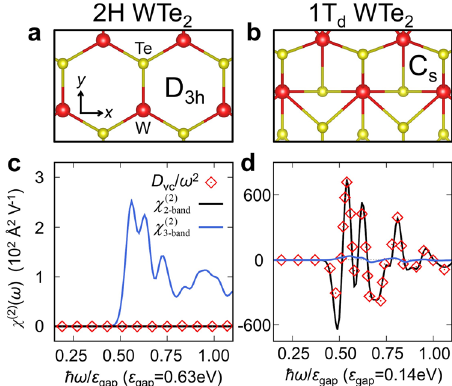
Fig. 4 The second harmonic Hall response of two polymorphs of monolayer WTe 2 . a The schematic for the 2H phase of WTe 2 with D 3h point group symmetry. b The schematic for the 1T d phase of WTe 2 with a two-fold symmetric C s point group. c The contributing terms to second harmonic generation susceptibility spectra (solid lines) and the interband Berry curvature dipole (red diamonds) for the 2H phase of WTe 2 . d The same for the 1T d the contribution χ ð 2 Þ and D E vc = ω 2 turned on in proportion to 2 (cid:4) band the fi eld strength, while those of χ ð 2 Þ are negligibly affected. 3 (cid:4) band